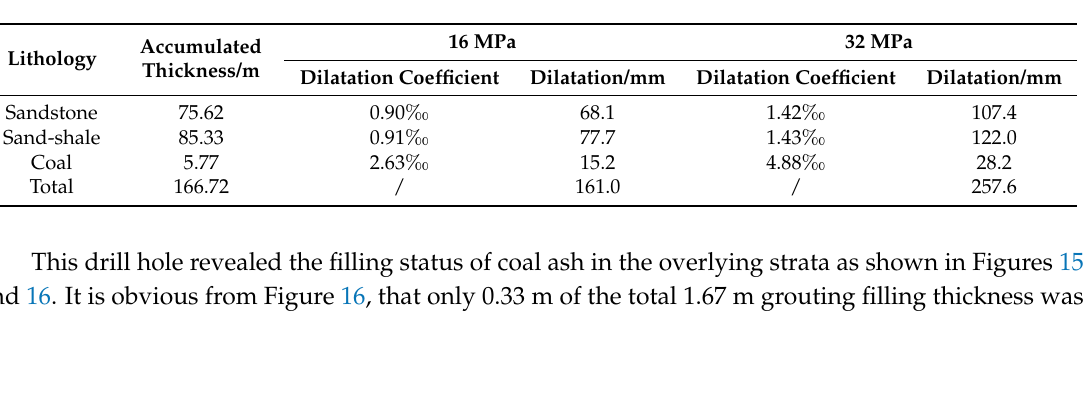
Table 3. Total amount of unloading dilatation with different